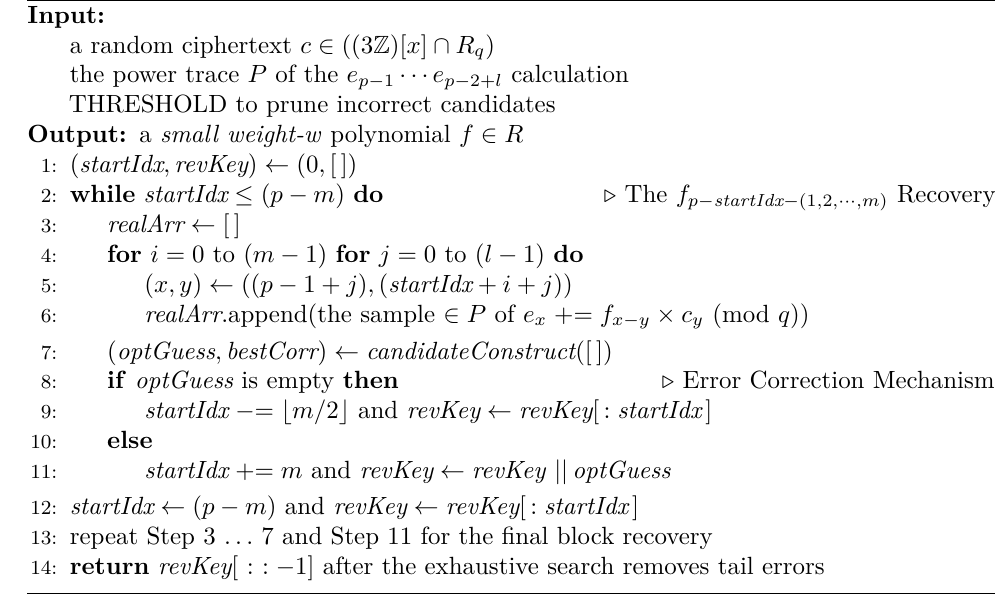
Algorithm 2 Horizontal In-Depth Correlation Power Analysis on NTRU